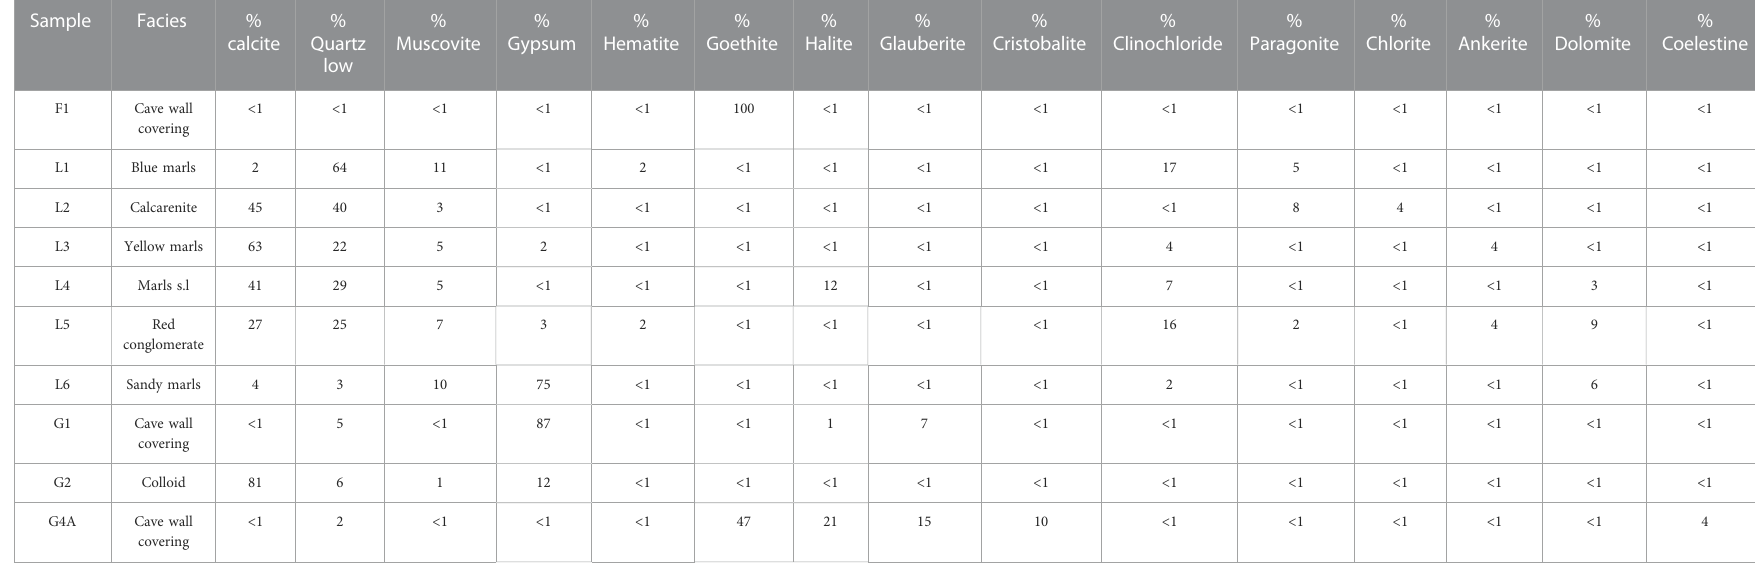
TABLE 4 Mineralogical compositions of the cave deposits and Miocene sediments in Carraclaca site based on XRD analyses. Sample Facies